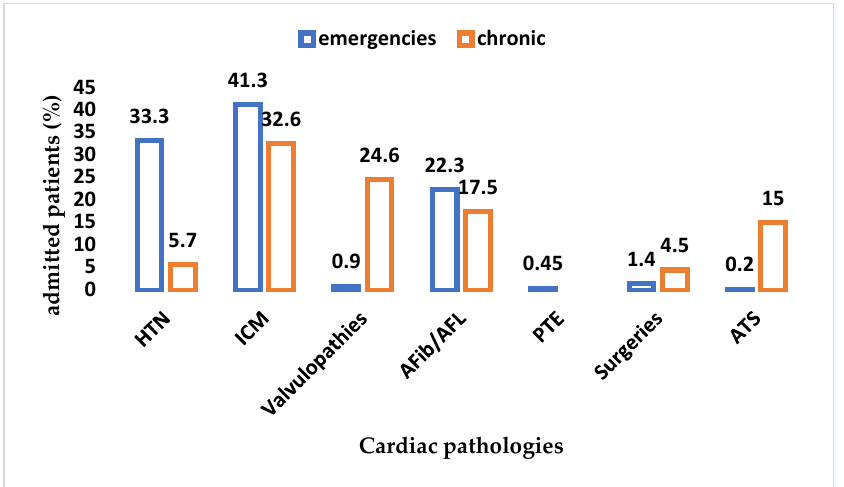
Figure 6. The distribution of cardiac disease by the admission mode in N-COV BATCH. HTN—arterial hypertension, ICM—ischemic cardiomyopathy, Afib—atrial fibrillation, AFL—atrial flutter, PTE—pulmonary thromboembolism, ATS—atherosclerosis. Table 1. Breakdown of batch COV-2 by age bracket.